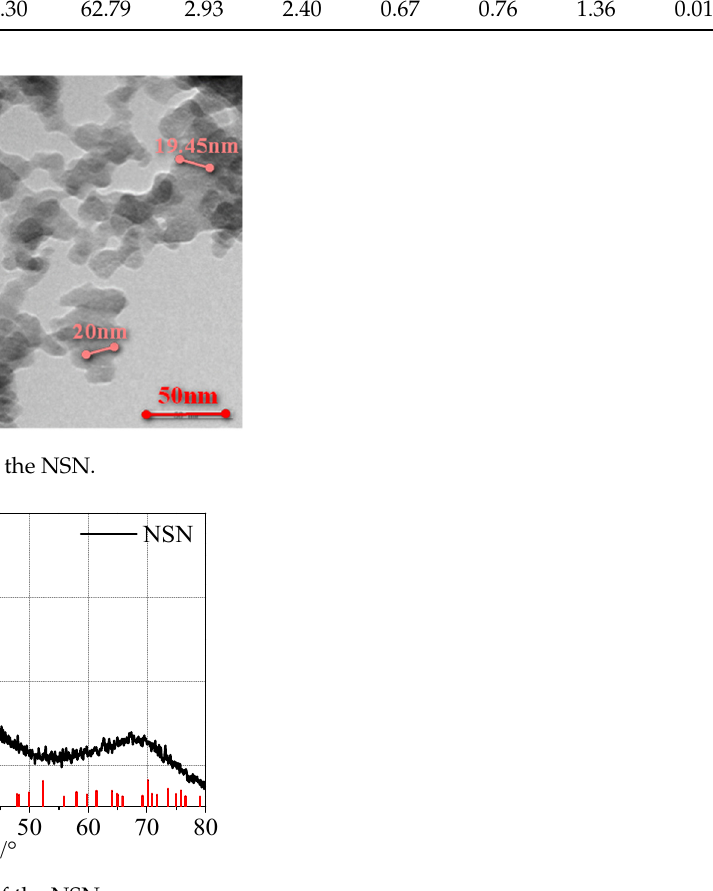
Figure 2. XRD pattern of the NSN.